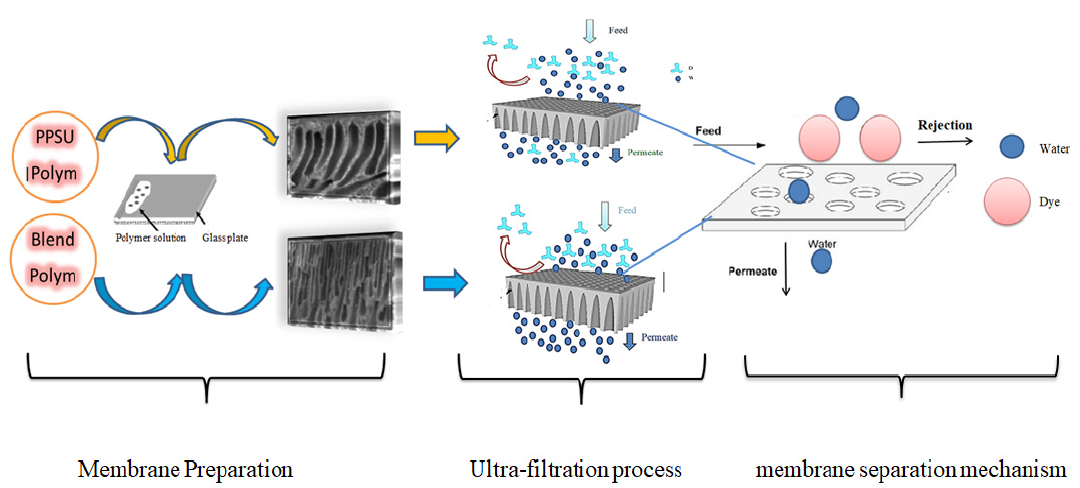
Figure 10. Effect of PES content on the membrane rejection for various feed dye concentrations.